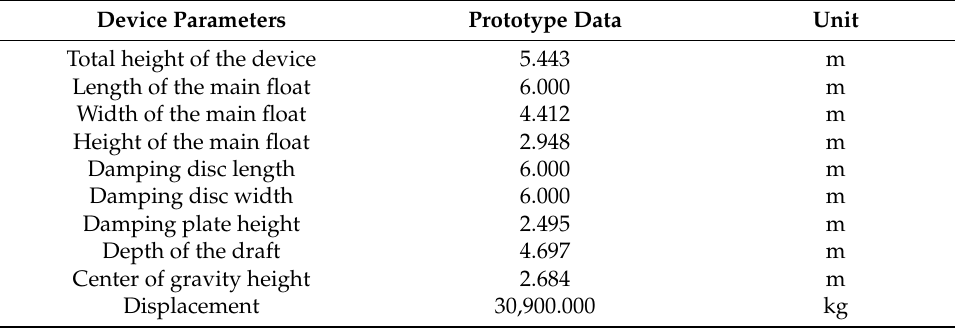
Table 1. The main size parameters of the rotor wave energy capture